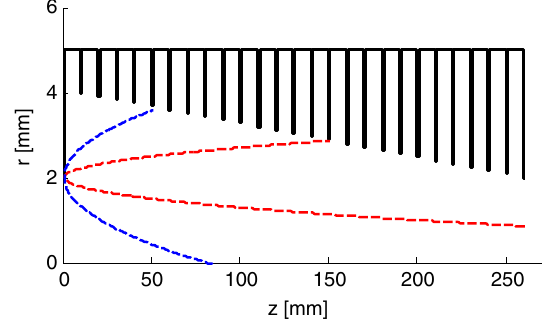
FIG. 1. Geometry of a sample structure is shown in the black solid line. Diffraction on the smallest iris is illustrated in red and blue dashed lines for different s : 5 and 50 (cid:2) m , respectively. numerically using the ECHO2D code [11]. For numerical simulations the tapered structure geometry presented in Fig. 1 has been repeated many times in order to arrive at the total length of the simulated structure much larger than the catch-up distance. This gives an asymptotic solution when the wakefields per meter length do not depend on the total length of the simulated structure. In our case, the criterion was that the change of the total loss factor per meter length is below 2 per mil when the total length is increased by factor 2. Simulations have been performed for two different bunch lengths (cid:1) : 10 and 5 (cid:2) m . The total z numbers of structures were 32 and 200, respectively.